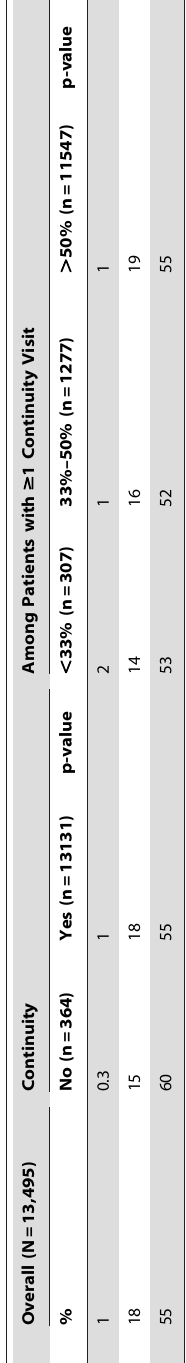
( Table 4 ). Analyzing odds ratios, individuals with medium and high levels of continuity were 31% less likely (AOR 0.69; 95% CI: 0.54, 0.92) and 41% less likely (AOR 0.59; 95% CI: 0.25, 0.76) to go to the ED compared to those with low continuity. Evaluating those individuals with low ( , 3 visits/year) versus high ( $ 3 visits/ year) primary care users, those with low usage were 73% less likely (AOR 0.27; 95% CI: 0.24, 0.29) to use the ED. Stratified Analysis, Sensitivity Analysis, Interactions To further evaluate the independence of the association between continuity and ED utilization, we calculated stratum- specific odds ratios for the number of primary care clinic visits during the study period instead of dichotomizing the population into ‘‘low’’ and ‘‘high’’ primary care users. These models, adjusted for the same covariates in Table 3, found a similar association between continuity and ED visits ( Table 5 ) for patients who had one visit (AOR 0.41; 95% CI: 0.24, 0.68) and two visits (AOR 0.39; 95% CI: 0.25, 0.61) in the year. However, the association between continuity on ED utilization did not reach statistical significance when looking at individuals with three, four, or five or more visits in the year. Because of the high proportion of patients with . 50% of their visits with continuity of care, the high continuity individuals were further categorized into patients with . 75% of their visits having continuity with their assigned PCP (data not shown). These patients were 51% less likely to utilize the ED compared to patients with low continuity (AOR 0.49; 95% CI: 0.38, 0.64).